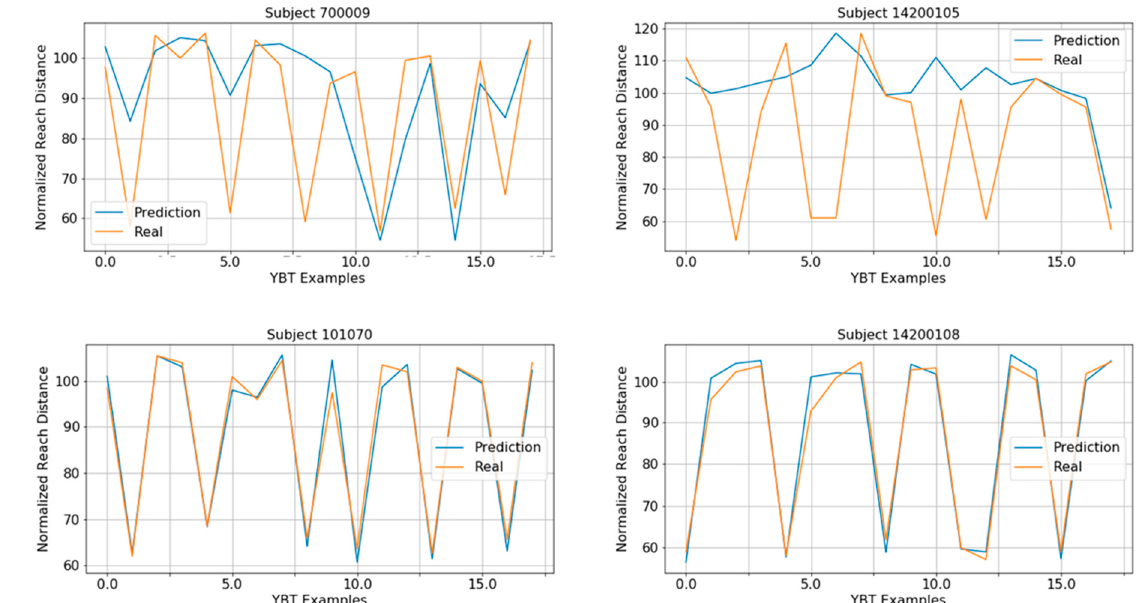
Figure 14. Real and predicted NRD of YBT from subjects with high MAPE ( top ) and subjects with low MAPE ( bottom ).